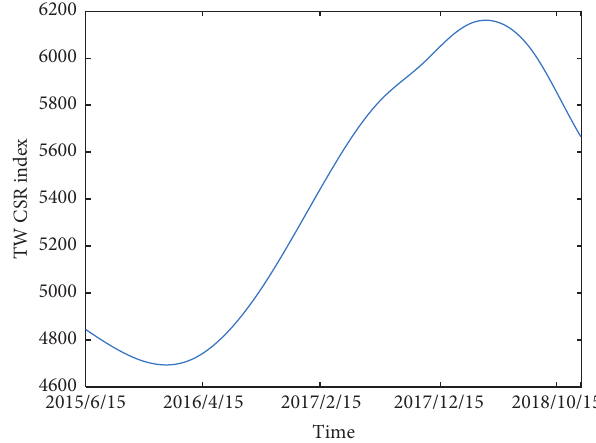
Figure 20: EMD analysis of the Taiwan CSR index used to get IMF6.